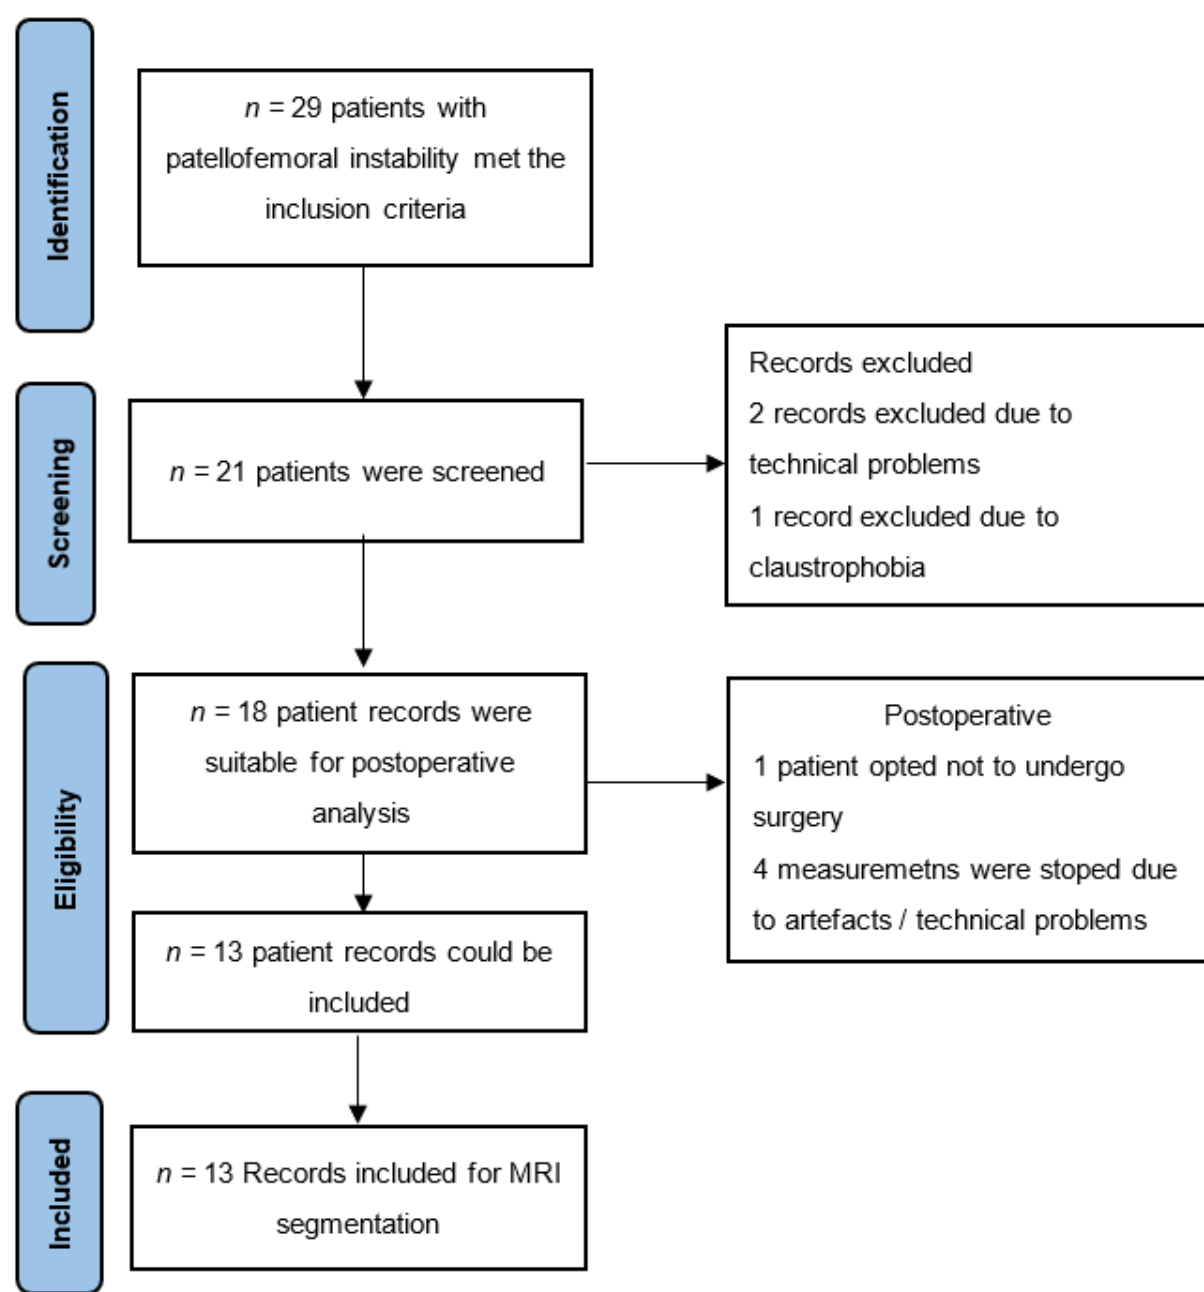
Figure 1. Patient selection process according to STROBE guideline.